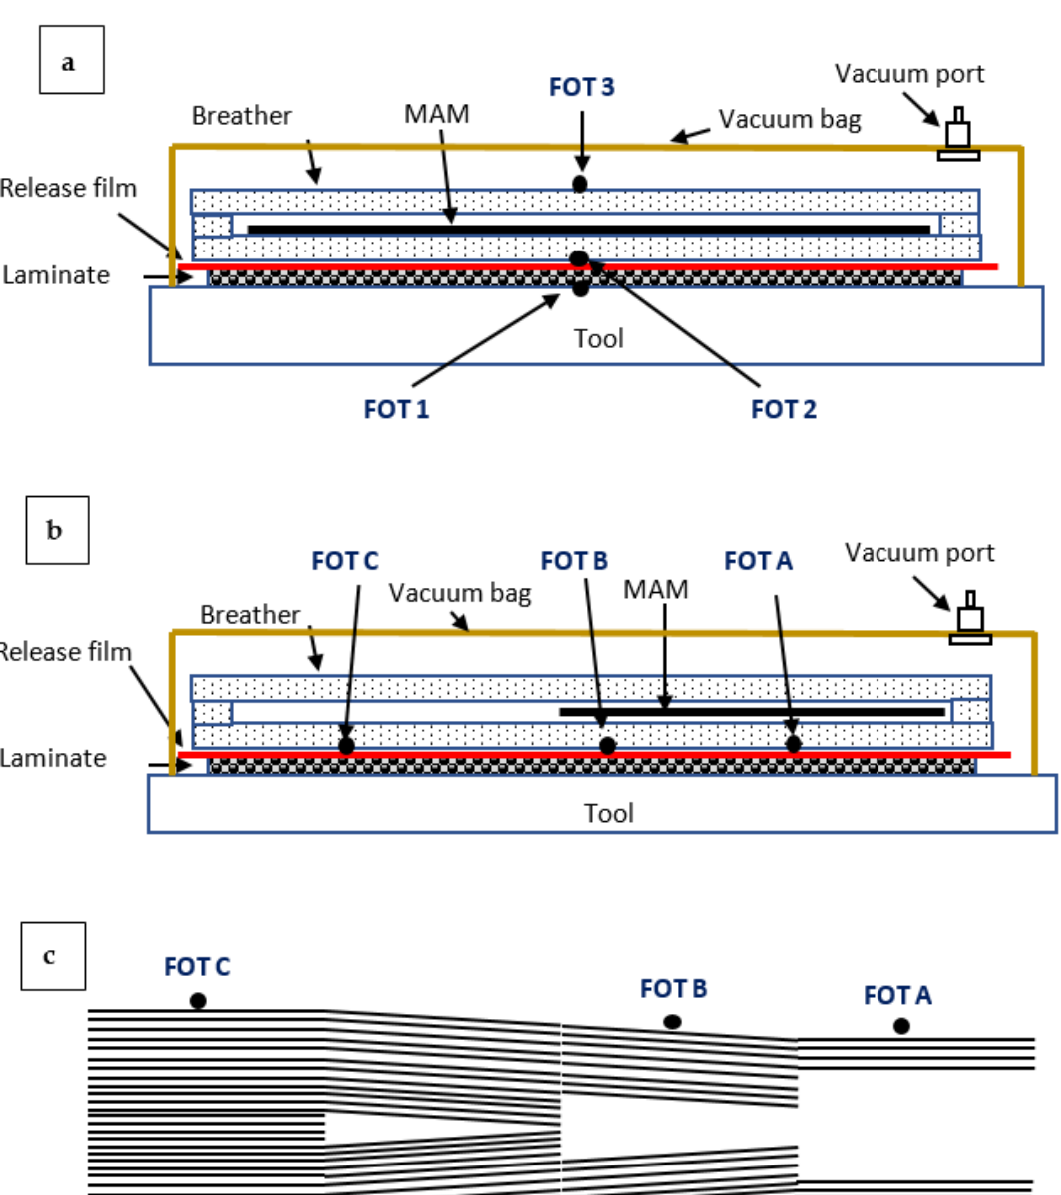
Figure 2. Schematic of the composite layup within the ( a ) test bed and ( b ) industrial microwaves (side of the microwave view). These diagrams specify the locations of the FOTs. A representation of the step geometry is shown in ( c ), where the internal ply drop for the panels can be seen .